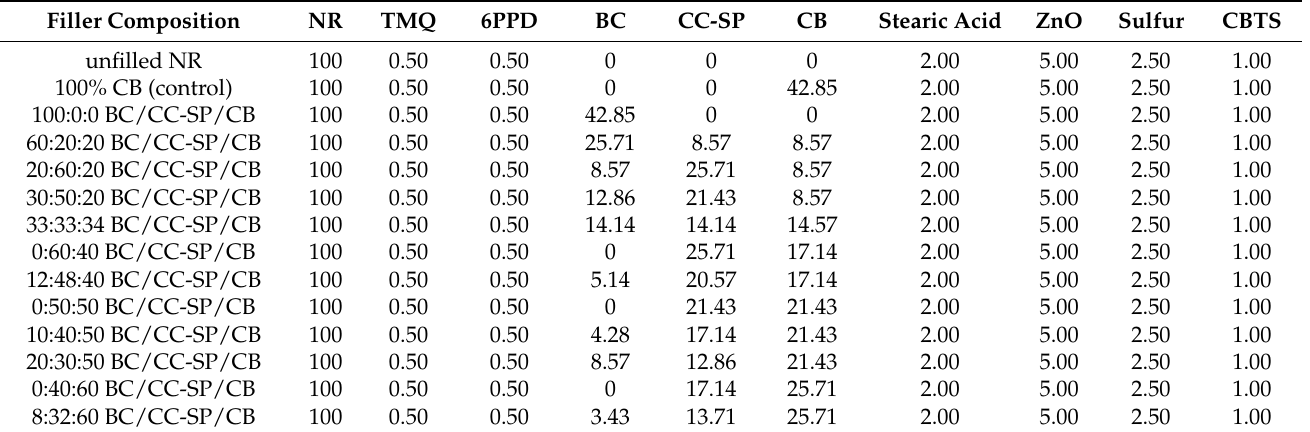
Table 1. The 30% total filler control and composite formulations